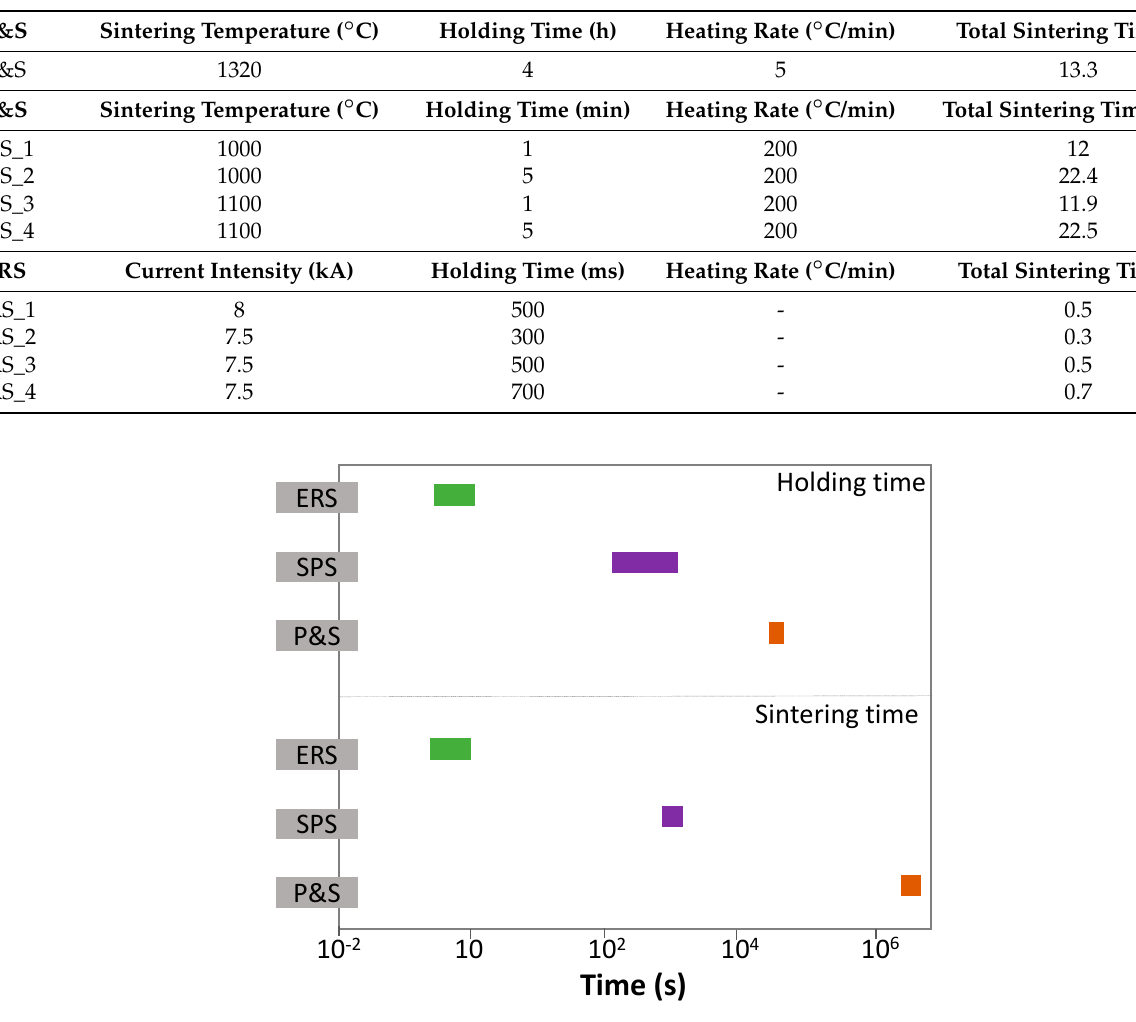
Table 2. Summary of conditions applied on sintering by conventional pressing and sintering (P&S), spark plasma sintering (SPS), and electrical resistance sintering (ERS).